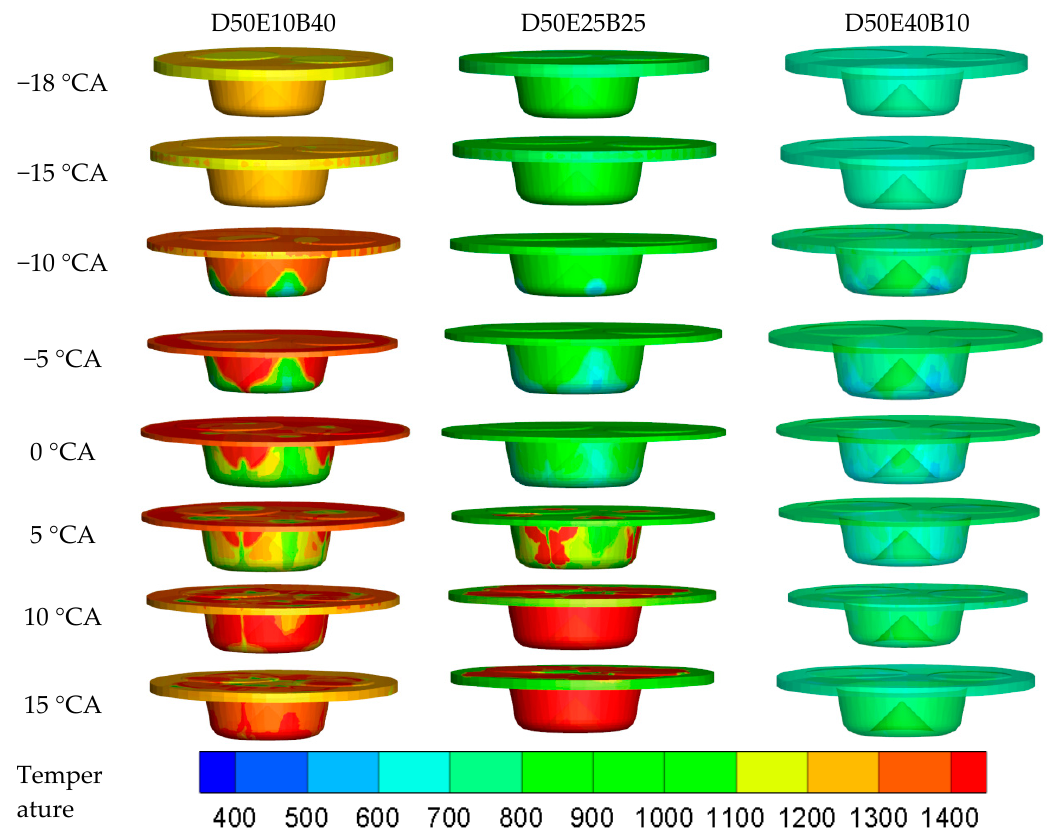
Figure 6. Three-dimensional (3D) view of ignitability difference between different diesel–ethanol–PME blends at 1600 RPM.